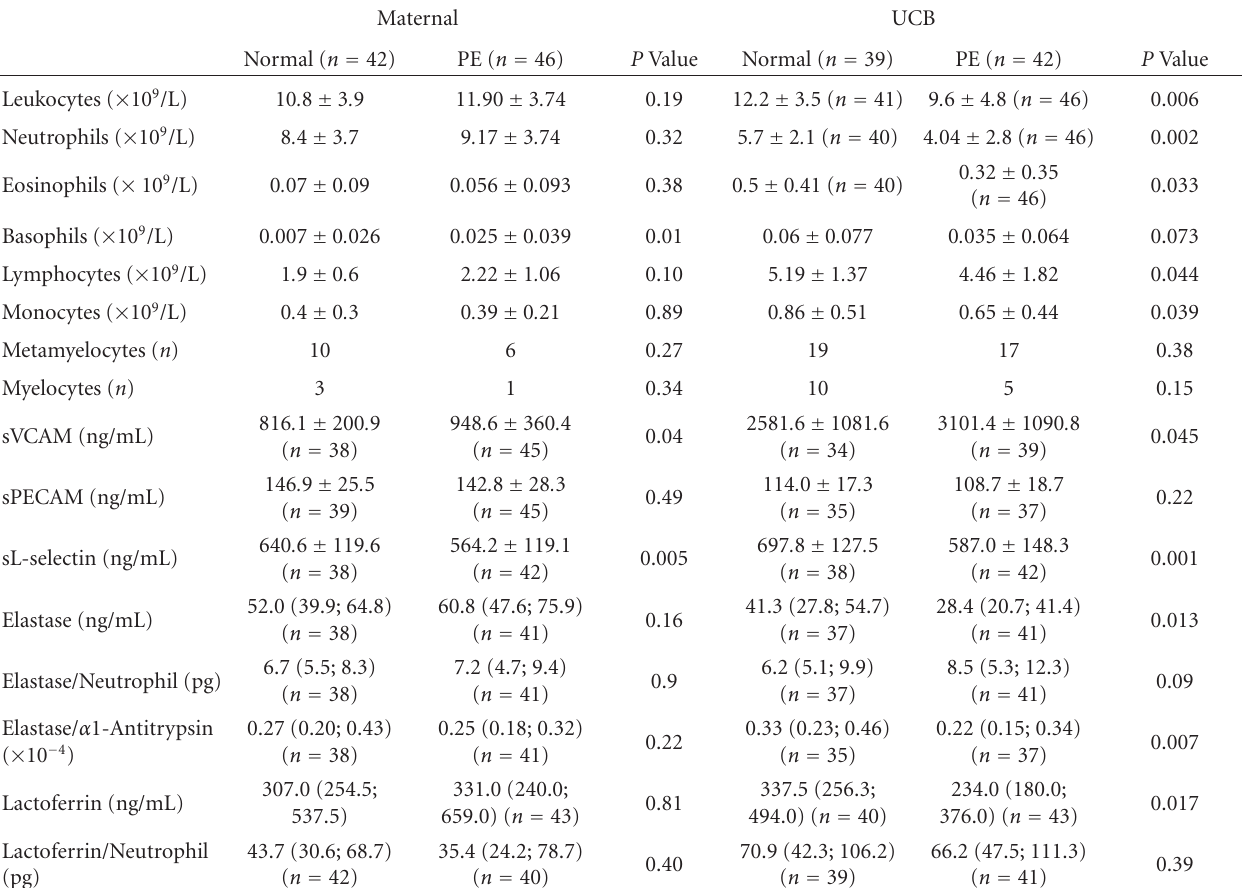
Table 3: Leukocyte activation parameters in maternal and umbilical cord blood, in normal and PE